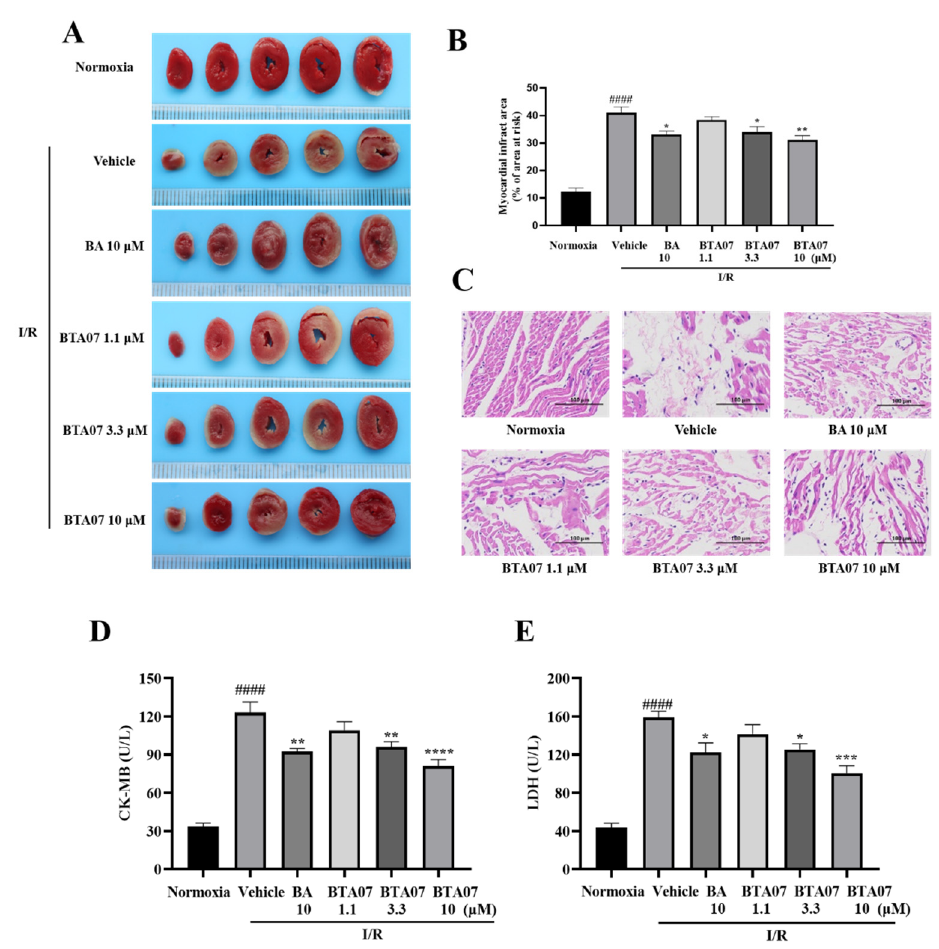
Figure 3. BTA07 ameliorates I/R-induced cardiac tissue damage in isolated rat hearts. ( A ) Representative images of myocardial infarct size by TTC staining. ( B ) Myocardial infarct sizes were presented as a percentage of the infarct area/total area. ( C ) Representative pictures of H&E-stained cardiac sections ( n = 5 per group). Magnification 200×, scale bar = 100 μ m. ( D ) Mean levels of lactate dehydrogenase (LDH) from the coronary outflow effluent in all groups. ( E ) Mean levels of creatine kinase-MB (CK-MB) from the coronary outflow effluent in all groups. Data are presented as means ± S.E.M for five independent experiments. #### p <0.0001 vs. normoxia group, **** p <0.0001vs. vehicle group; *** p <0.001vs. vehicle group; ** p < 0.01vs. vehicle group; * p < 0.05 vs. vehicle group; one − way